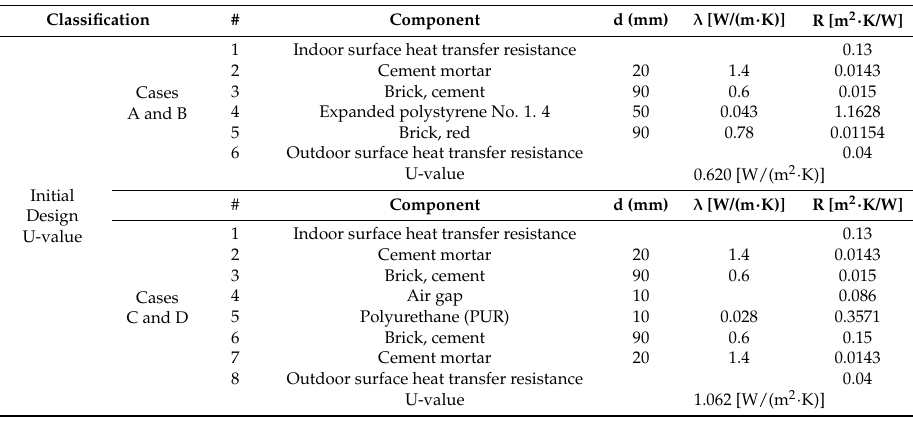
Table 4. Thermophysical properties at initial